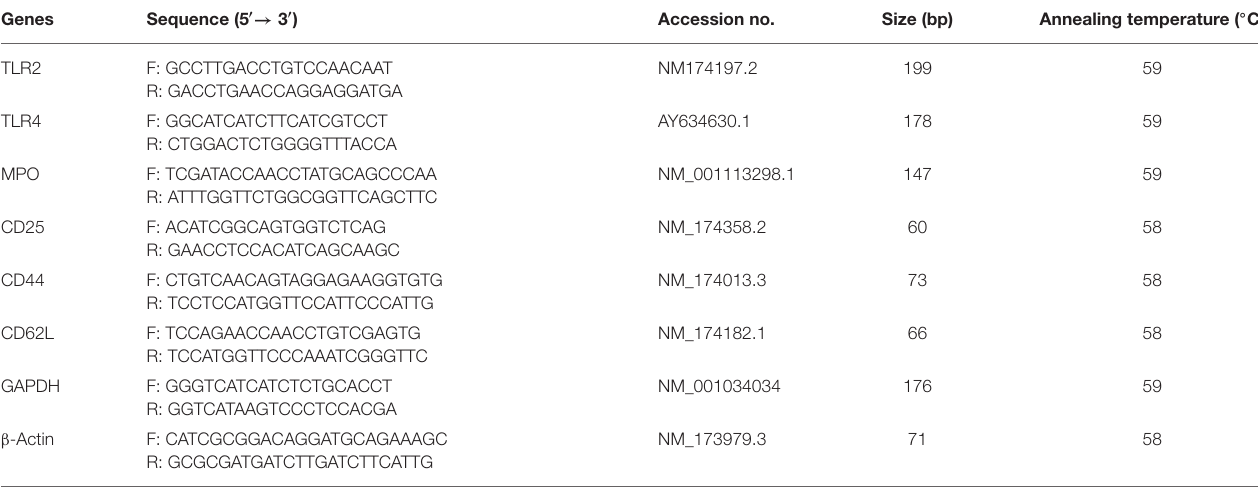
TABLE 1 | Details of various primers used in the study. Genes